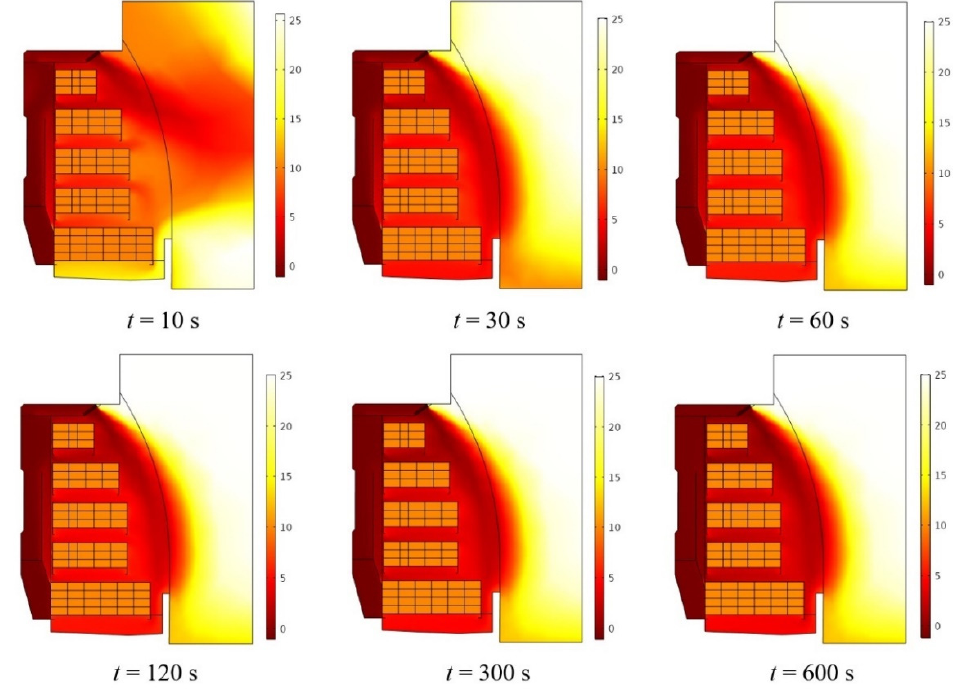
◦ C) distribution in the middle plane of the modified Figure 9. Temperature (°C) distribution in the middle plane of the modified cabinet. Figure 9. Temperature (